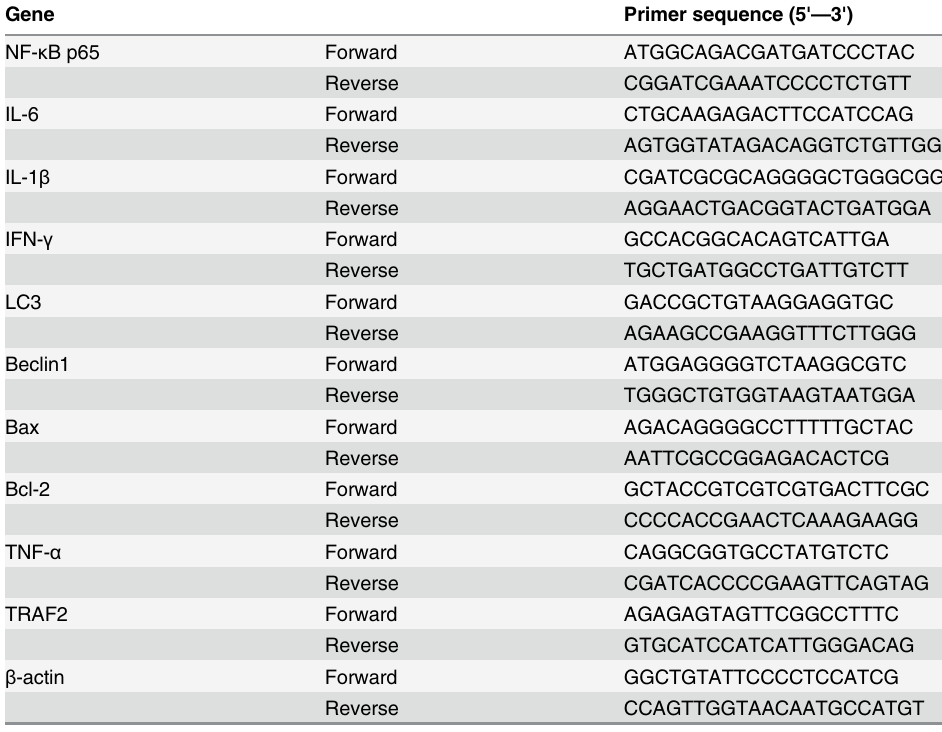
Table 1. Nucleotide sequences of primers used for